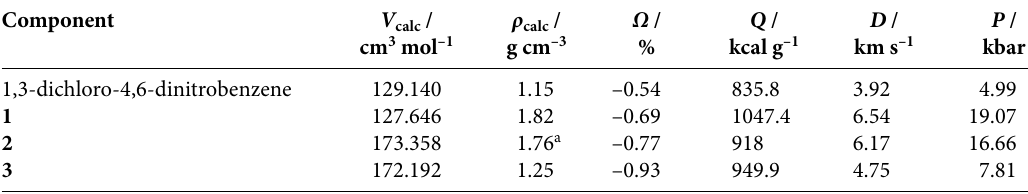
Table 8. Calculated detonation properties of the energetic materials prepared.